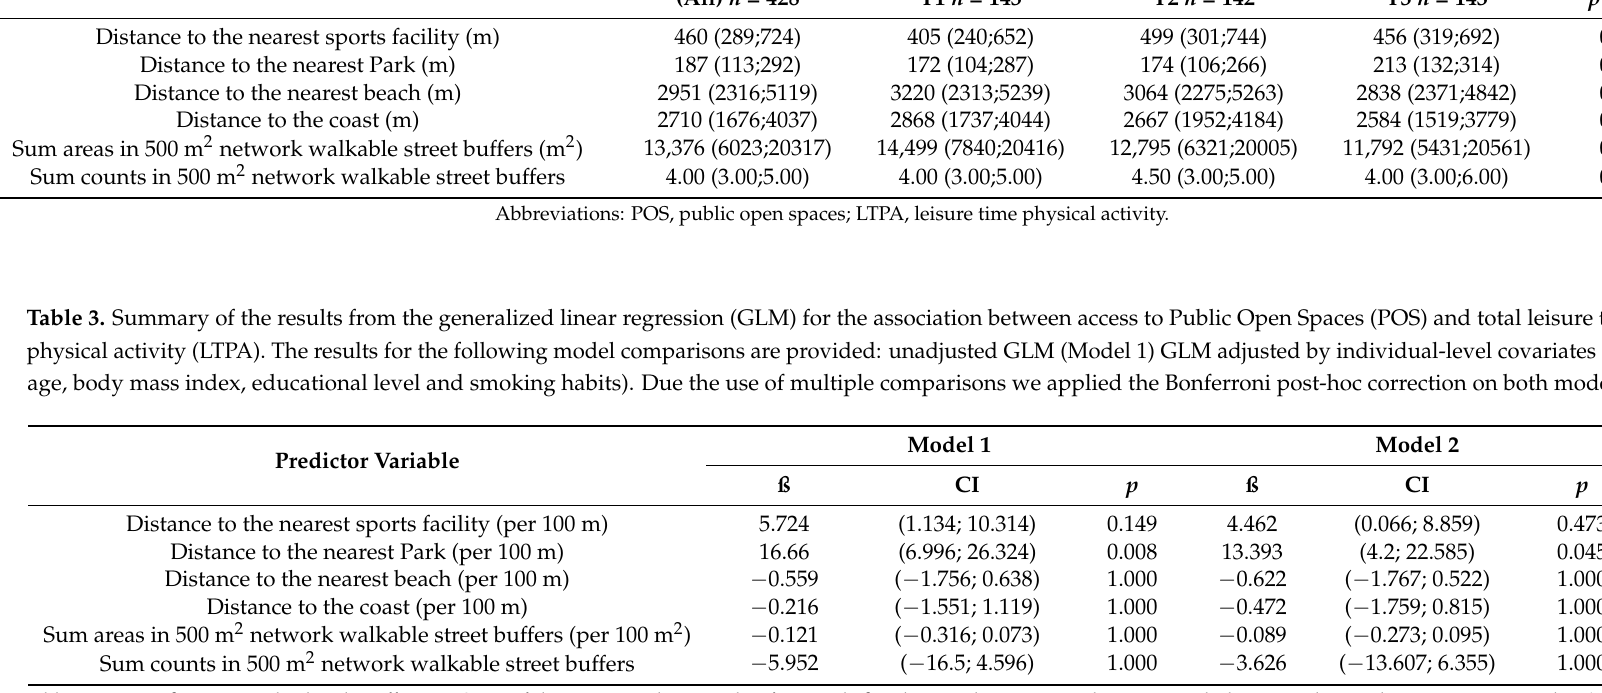
Abbreviations: ß, non-standardized coefficient; CI, confidence interval; p , p-value for trend. ß indicates change in total LTPA Metabolic equivalent task per minutes per day (METs min/day) per increment (in 100 m, 100 m 2 or count) in access to public open spaces (POS). Model 1: unadjusted linear regression. Model 2: linear regression adjusted by individual-level covariates (sex, age, body mass index, educational level and smoking habits). Due the used of multiple comparisons we applied the Bonferroni post-hoc correction on both